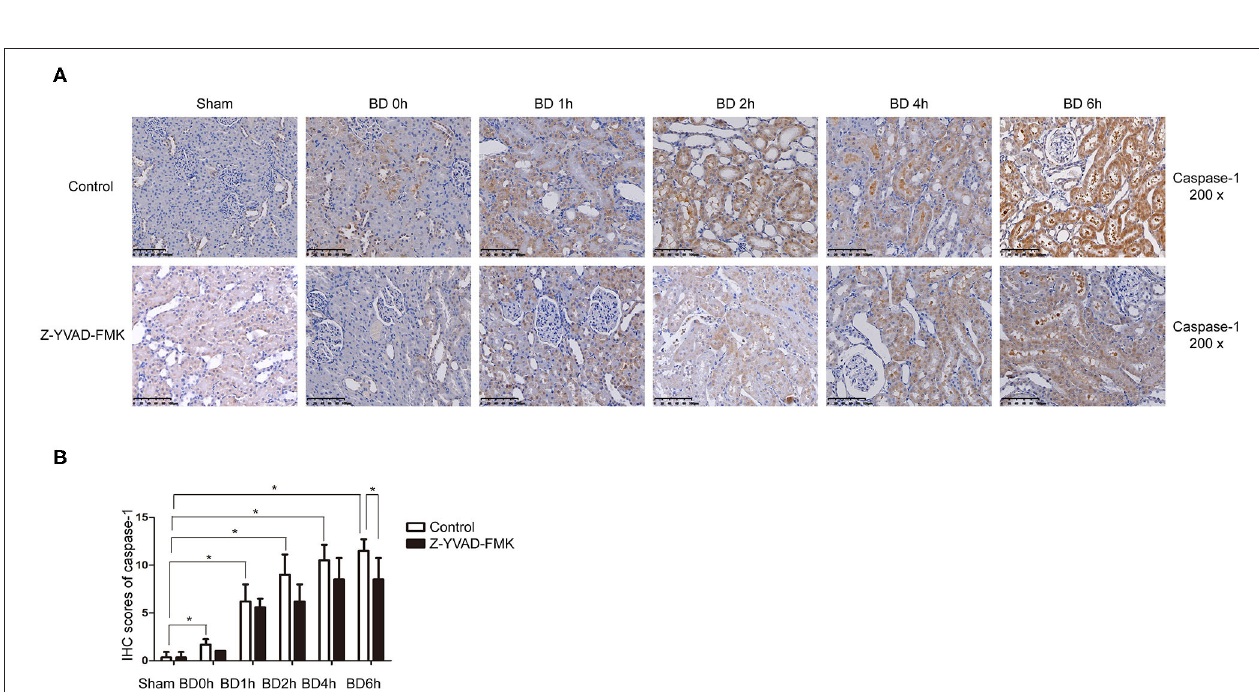
FIGURE 1 | HE staining, Paller scores and renal function results in control cohort and Z-YVAD-FMK-treated cohort. There were sham, 0, 1, 2, 4, and 6h group ( n = 6 in each group) in each cohort. HE appearance after (A) . Paller score (B) . Serum creatinine levels (C) . Urea levels (D) . * p < 0.05. BD = brain-death; Sham = without brain death; HE = Hematoxylin and eosin.